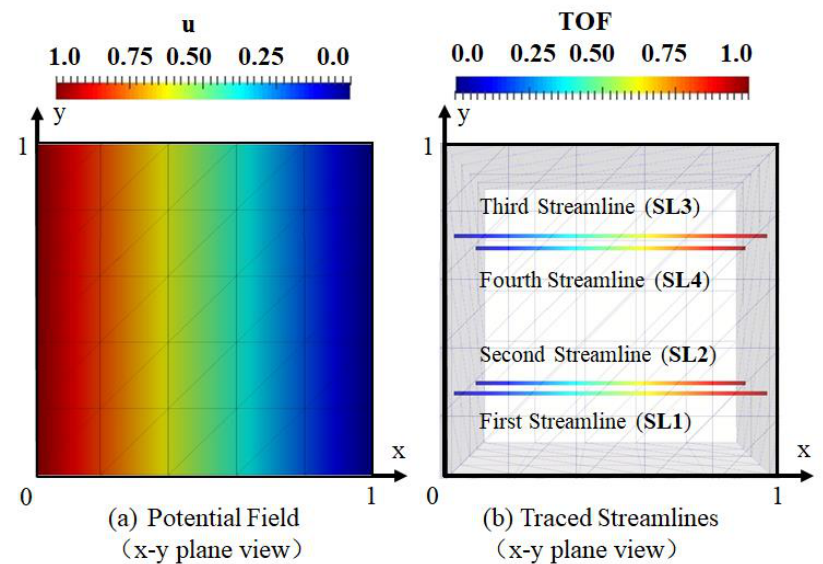
Figure 5. The simple fluid flow problem (Case 1) to verify the process of tracing streamlines for the whole domain where ( a ) shows the fluid field, u, and ( b ) shows four traced streamlines whose start points are at (0.0,0.25,0.25), (0.0,0.25,0.75), (0.0,0.75,0.25), and (0.0,0.75,0.75), respectively.